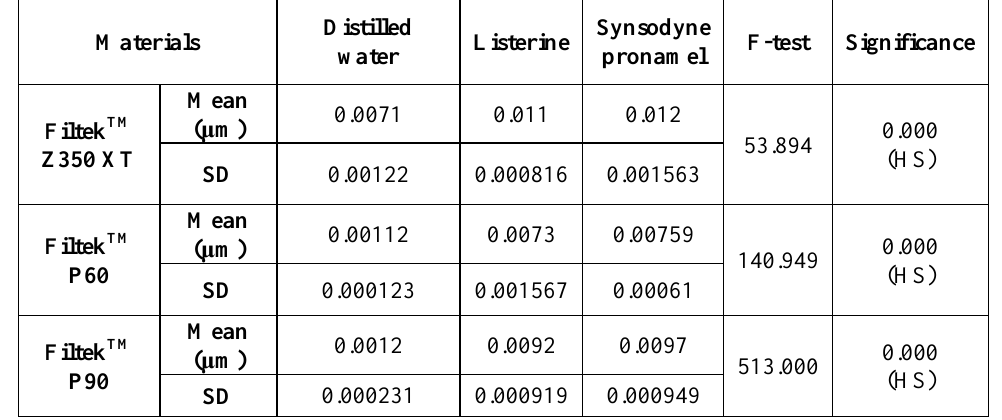
Table 3: Descriptive statistics of surface roughness values in μ m for all groupsand statistical analysis of data by (ANOVA) among the three treatment solution against each type of composite Materials